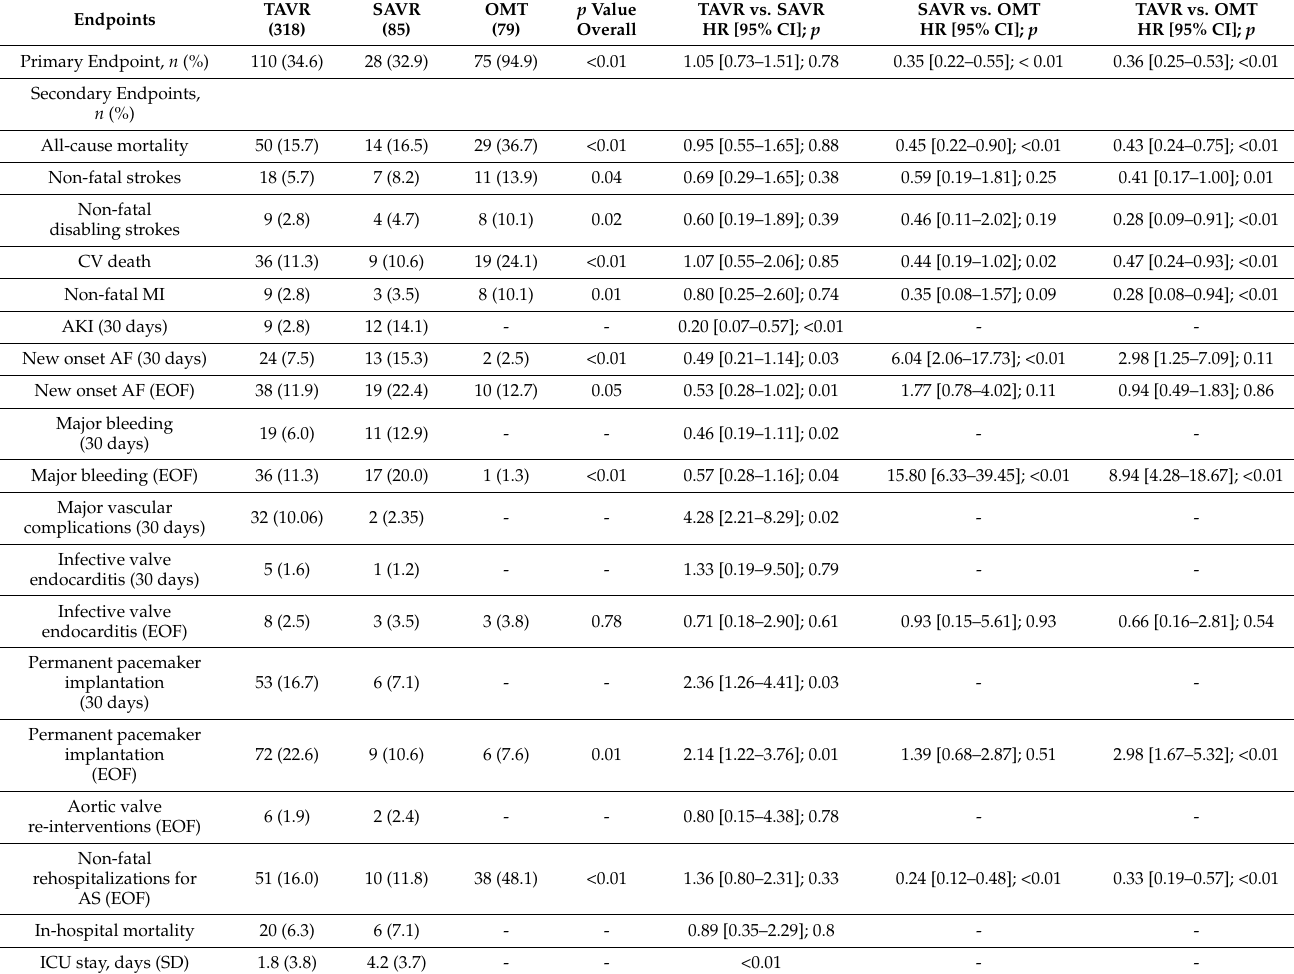
Table 3. Primary and secondary endpoints.